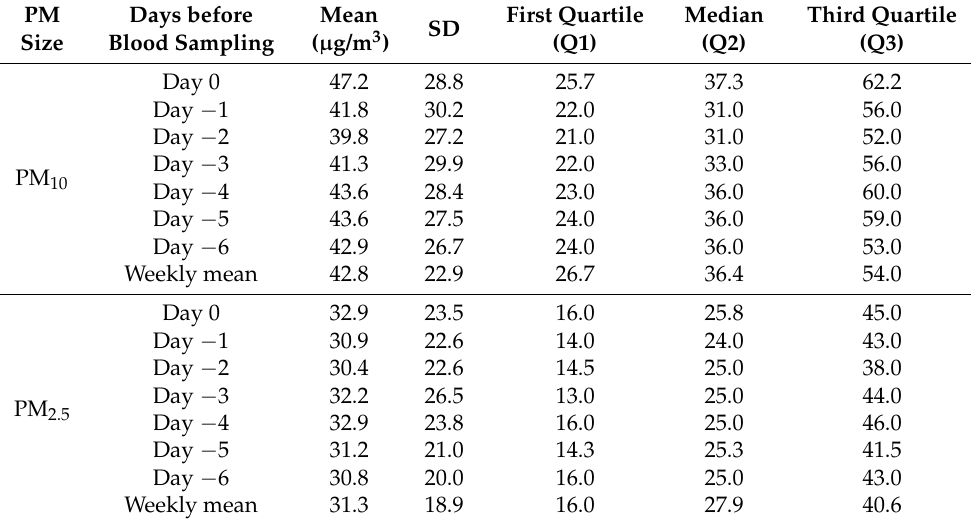
Table 3. PM concentrations recorded by ARPA Lombardia monitoring